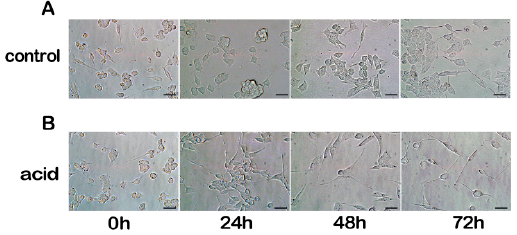
Figure 1. Differentiated and undifferentiated MN9D cells. MN9D cells were observed by fluorescence microscopy at 0, 24, 48, and 72 h after plating. ( A ) Undifferentiated MN9D cells were plated in complete growth medium; ( B ) MN9D cells were plated in complete growth medium plus 1 μ M retinoic acid. (Scale bar = 20 μ m).